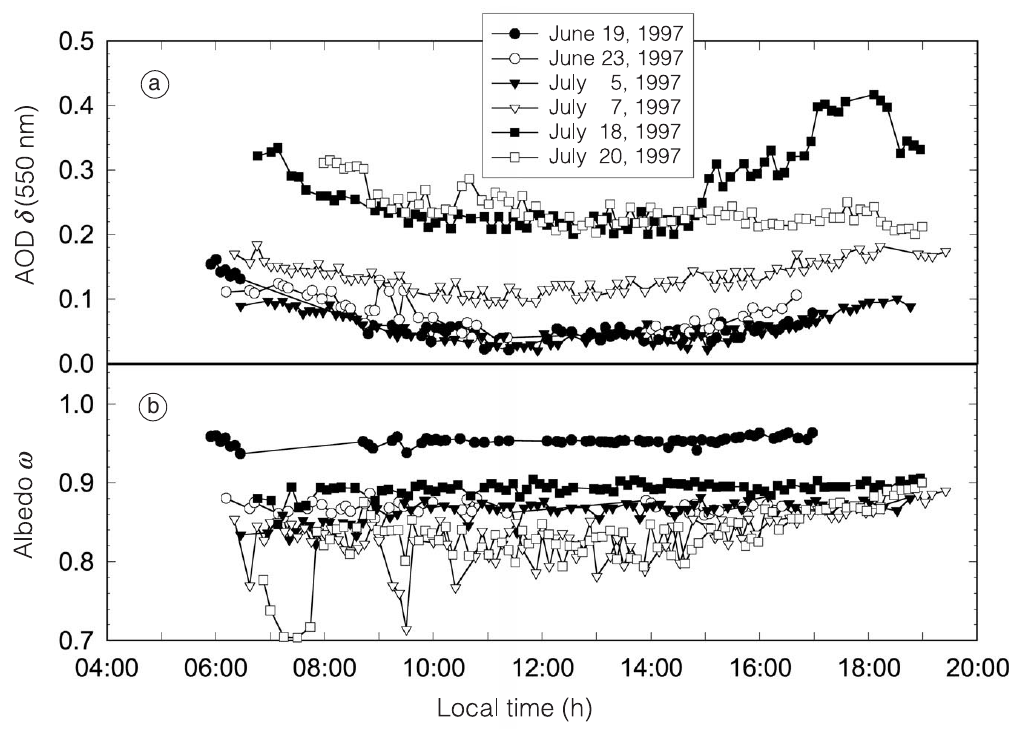
Fig. 3a,b. a) Time-patterns of aerosol optical depth d (550 nm) measured on the six selected days; b)